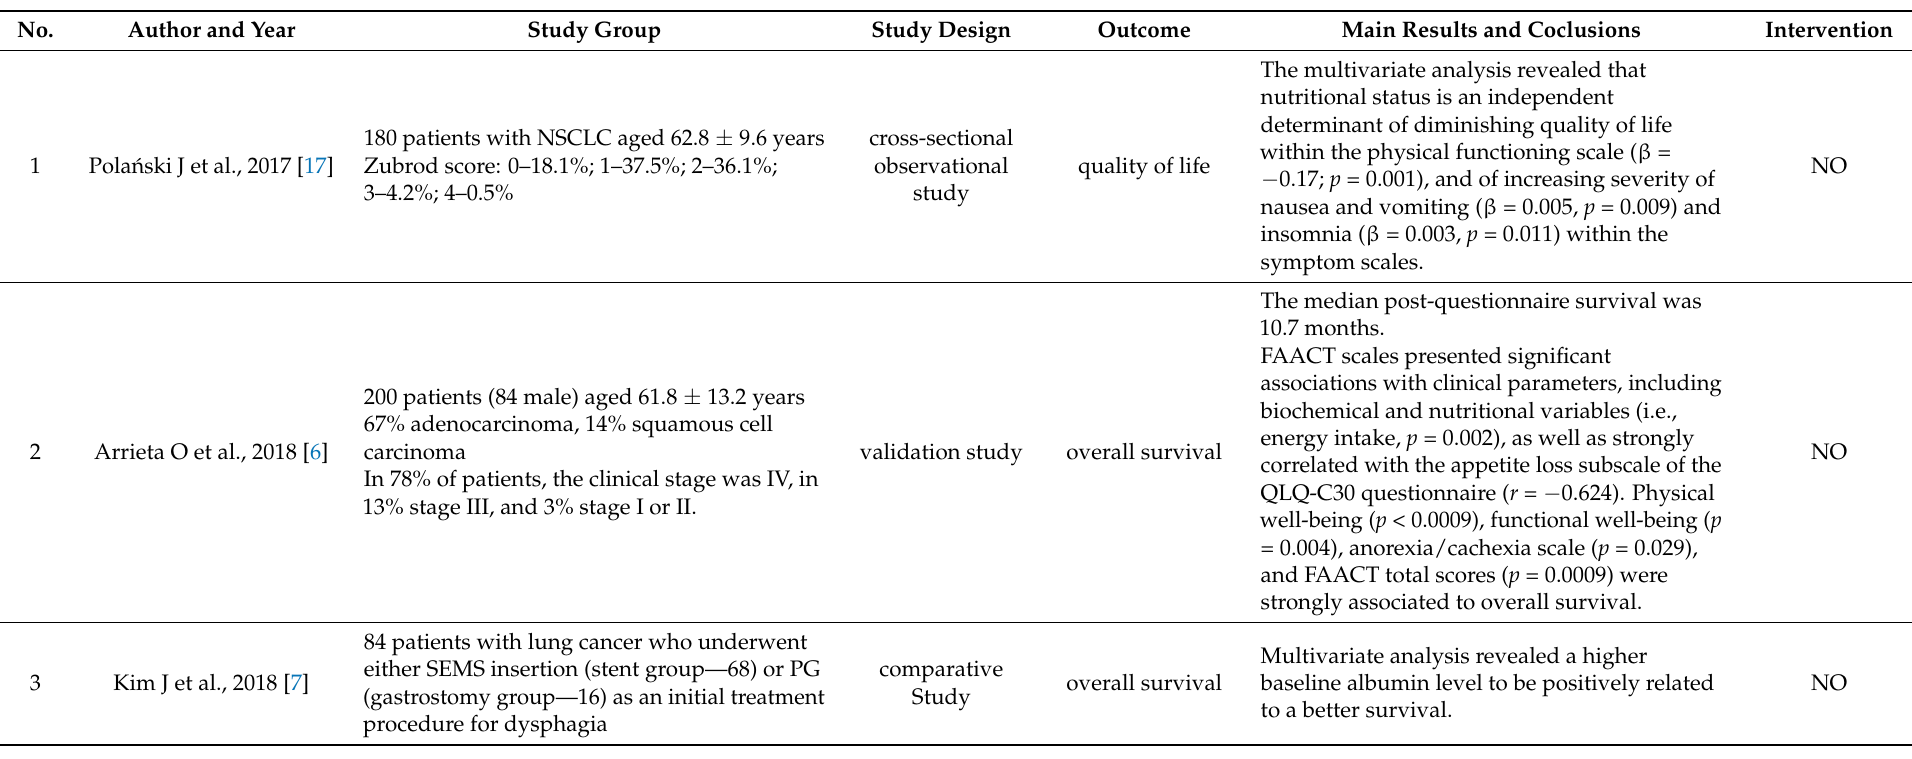
Table 1. Summary of studies: INI—Inflammatory-Nutritional Index; OS—overall survival; NSCLC—Non-small-cell lung carcinoma; FAACT—The Functional Assessment of Anorexia/Cachexia Therapy; SEMS—self-expandable metallic stents: PG—percutaneous gastrostomy; AD—adenocarcinoma; PNI—the prognostic nutritional index; Icrt—comprised of induction chemoradiotherapy; MNA—mini-nutritional assessment; SGA—Subjective Global Assessment; BMI—body mass index; AC/S—anorexia-cachexia subscale; TTP—time-to-tumor progression; LOS—length of hospital